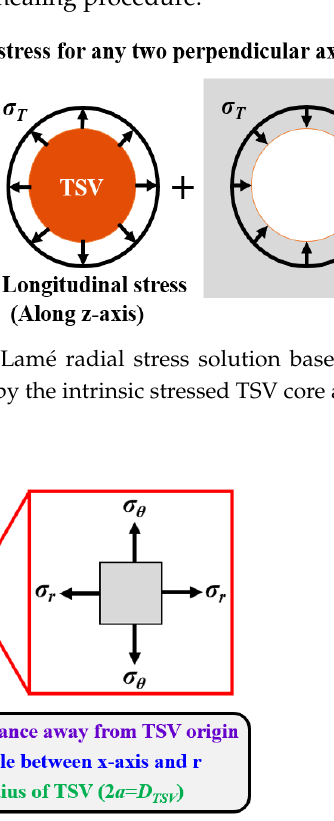
Figure 2. Schematic of TSV stress-affected zone calculation and corresponding structural parameters. The enlarged figure on the right side refers to the stress element in any location on the Si top surface.